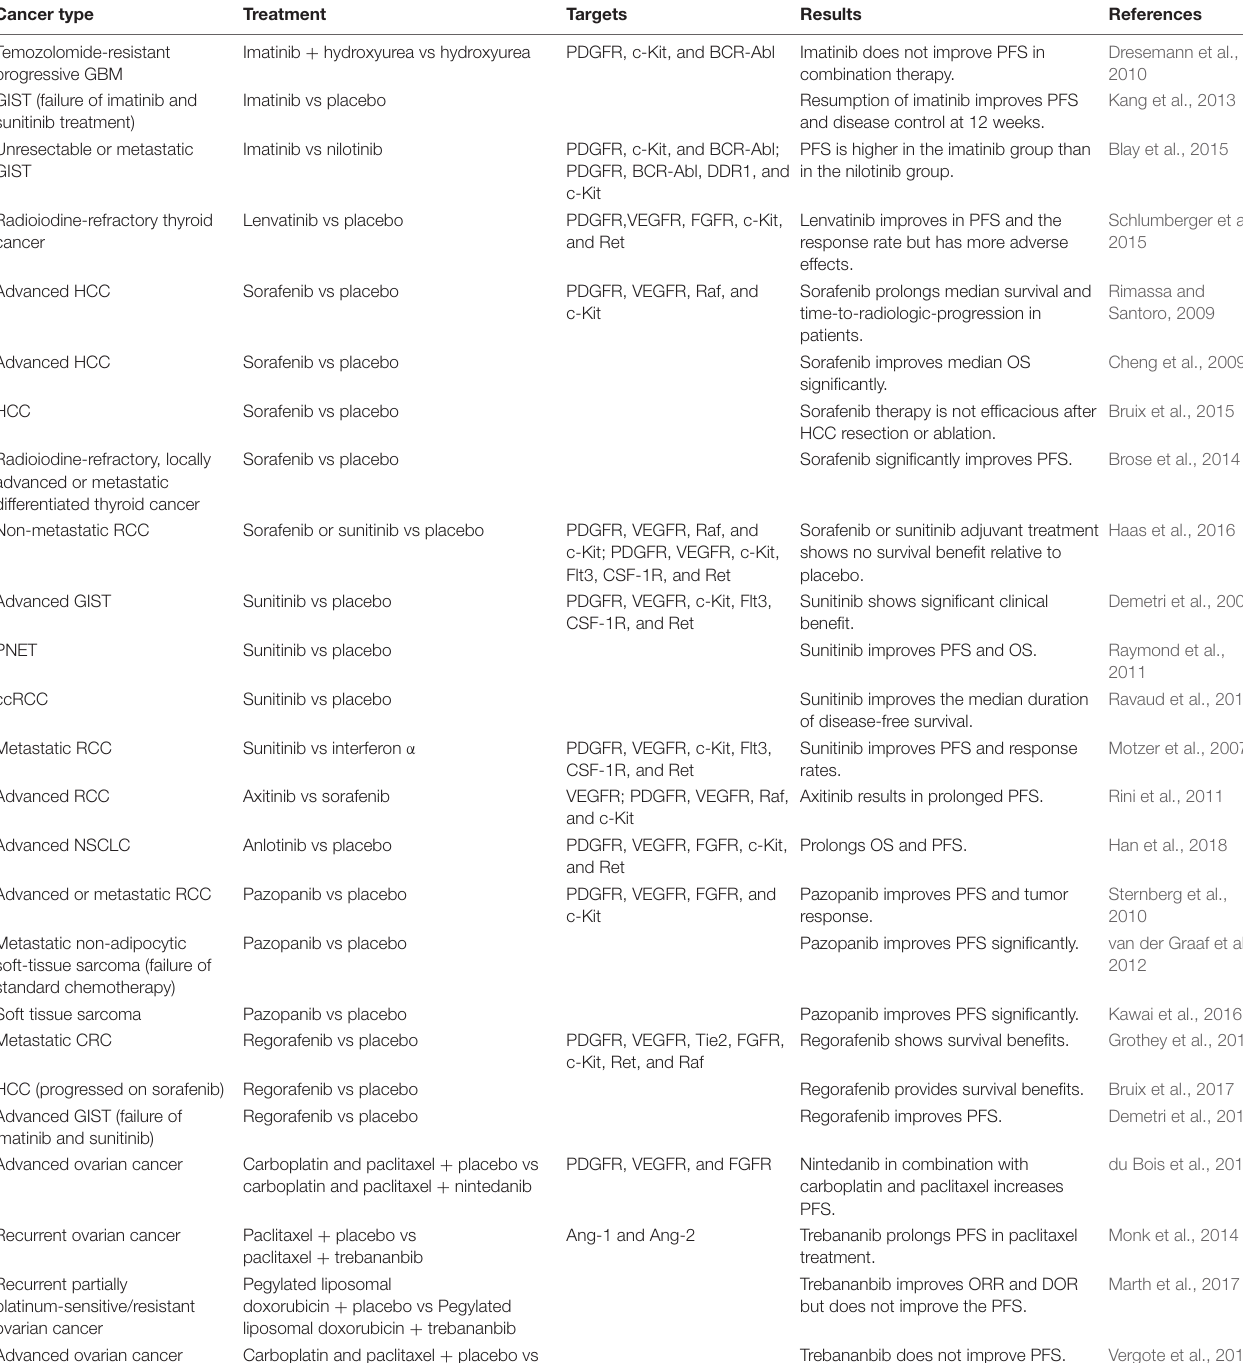
TABLE 1 | Phase 3 clinical trials of Pericyte-related antitumor